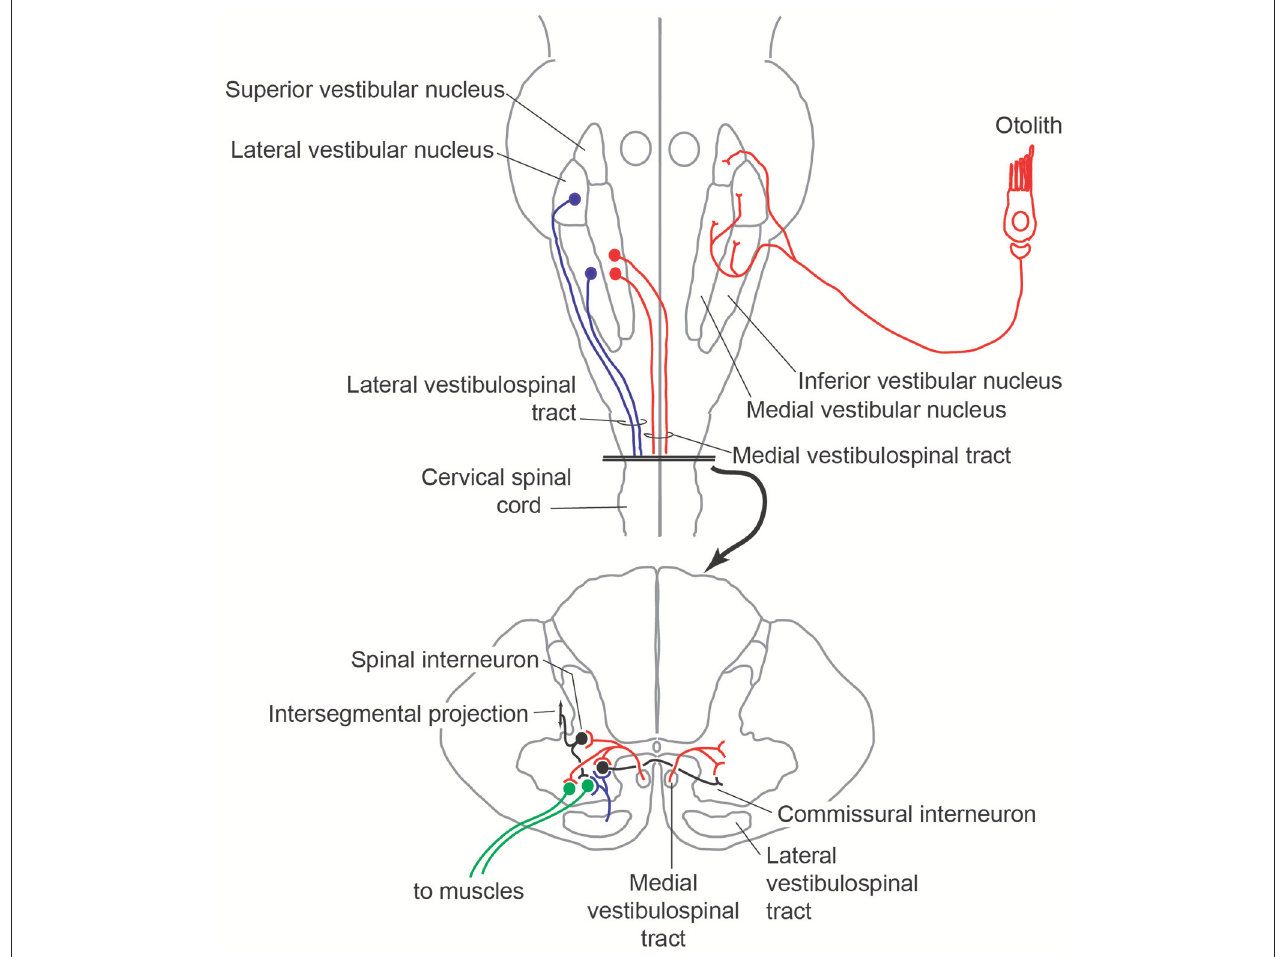
FIGURE 2 | Trajectory of medial and lateral vestibulospinal tracts, and interface within intrinsic spinal